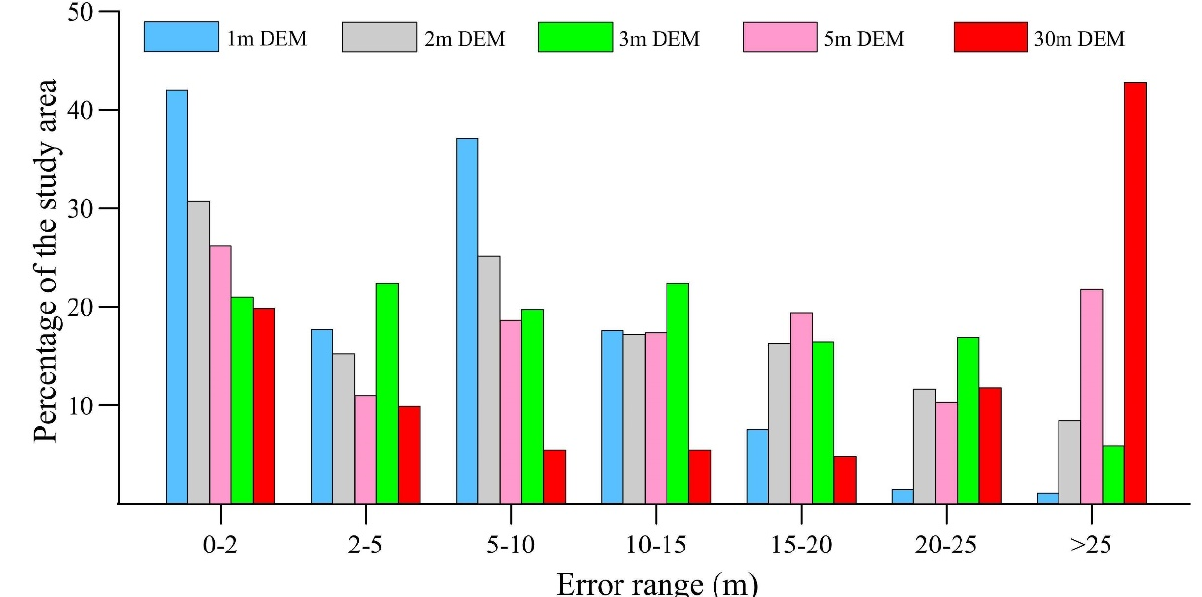
Figure 9. Statistical distribution of the horizontal error for all five simulated models.